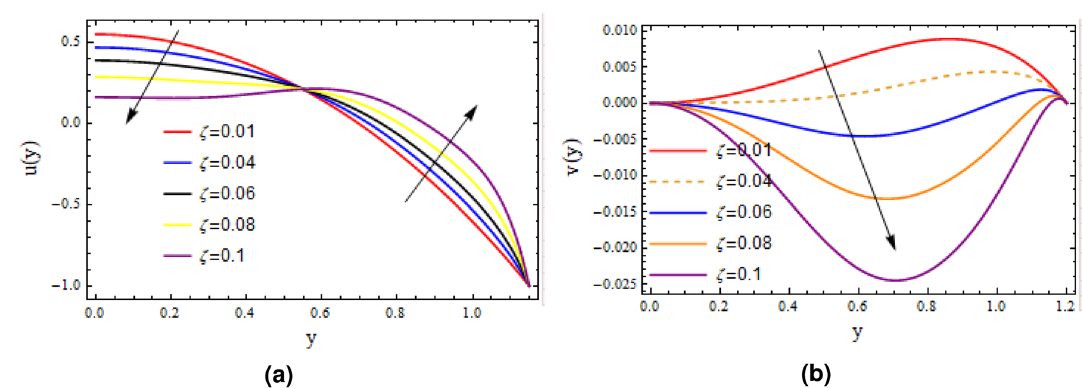
Figure 5. Velocity profile variations with ( a ) and ( b ) α = 0.2 , ε = 0.15 , δ = 0.01 , F = 0.1 , x = 1